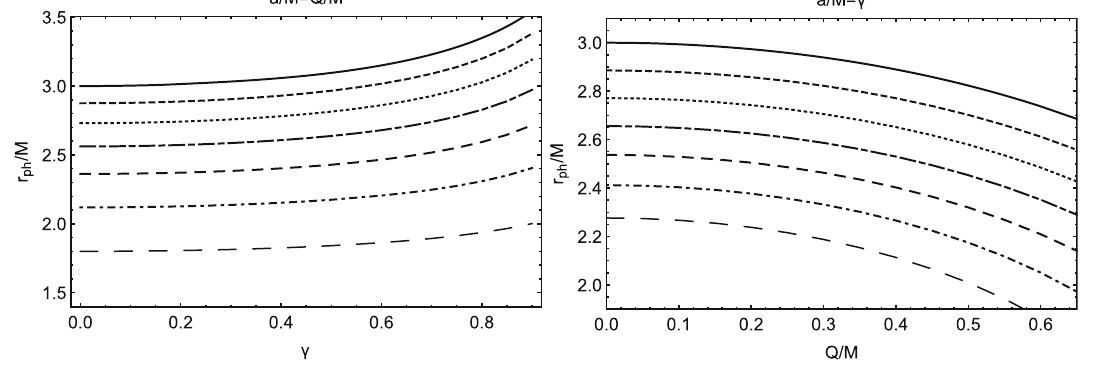
Fig. 3 The photon orbits by varying γ and Q . In the left and right panel from top to bottom the values of Q and γ are 0, 0.1, 0.2, 0.3, 0.4, 0.5 and 0.6,